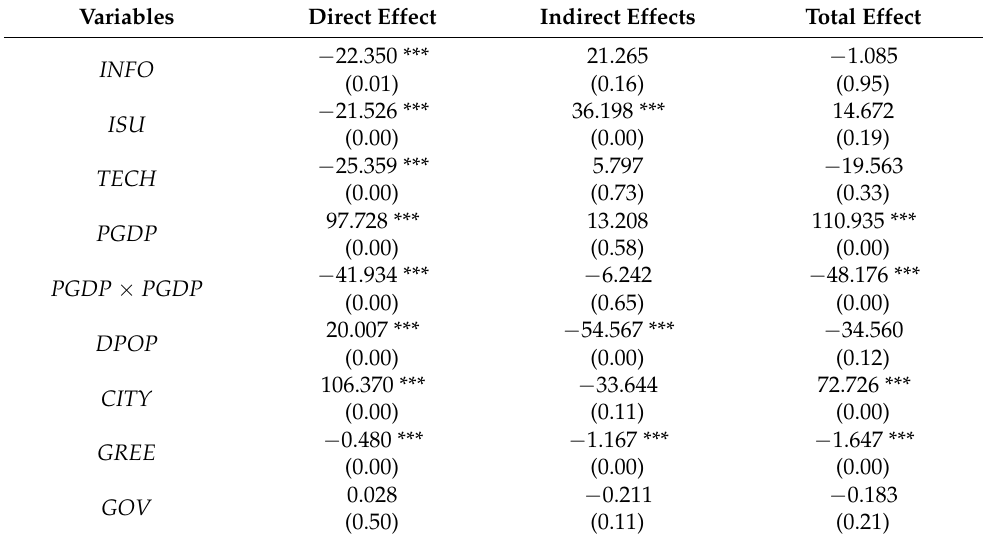
Table 5. The direct and indirect effect of independent variables on the air